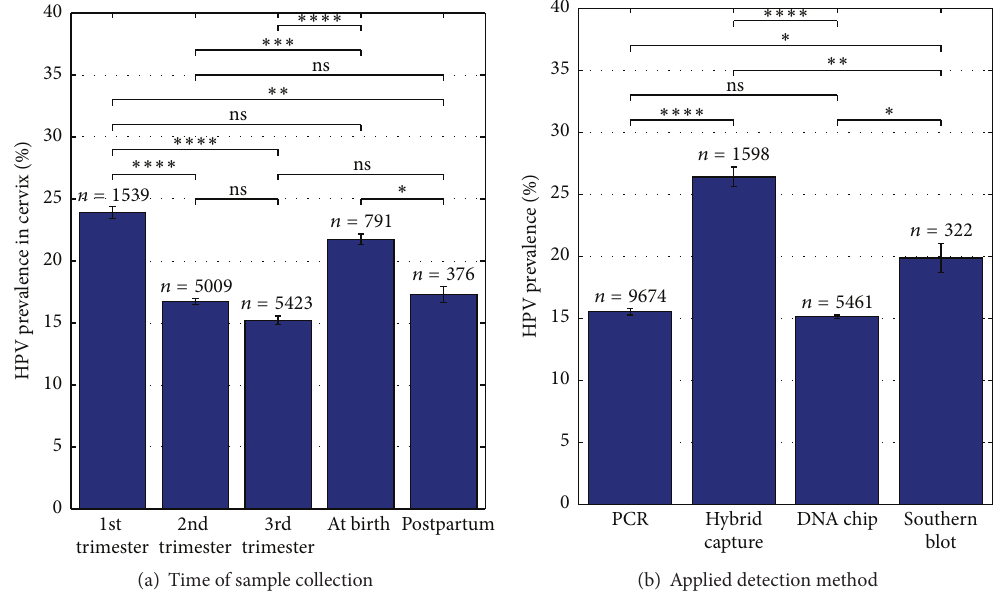
Figure 5: HPV prevalence depends on time of sample collection and on the applied HPV detection method. (a) Cervical HPV prevalence in % at different time points of sample collection of normal pregnancies. 25 studies have been included in the present analysis, 𝑁 1 st trimester = 10 , = 10 , 𝑁 = 18 , 𝑁 = 4 , and 𝑁 = 4 . (b) HPV prevalence in % in relation to the detection method used. 𝑁 2 nd trimester 3 rd trimester at birth postpartum Note that only two studies were using Southern blot as their main detection method. 45 studies have been included in the present analysis, = 34 , 𝑁 = 8 , 𝑁 = 5 , and 𝑁 = 2 . 𝑁 indicated number of studies included. 𝑛 indicates number of cases 𝑁 PCR hybrid capture DNA chip Southern blot included. ∗ 𝑃 < 0.05 , ∗∗ 𝑃 < 0.01 , ∗∗∗ 𝑃 < 0.001 , and ∗∗∗∗ 𝑃 < 0.0001 ; ns: not